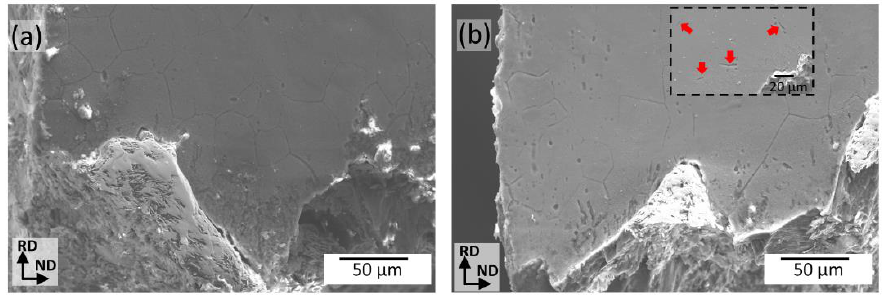
Figure 9. SEM micrographs near the fracture surface of ( a ) ZX11-350 and ( b ) ZX11-450 samples tested in tension after 15 days of immersion. Inset in ( b ) shows a typical crack nucleation along twins in the ZX11-450 samples.